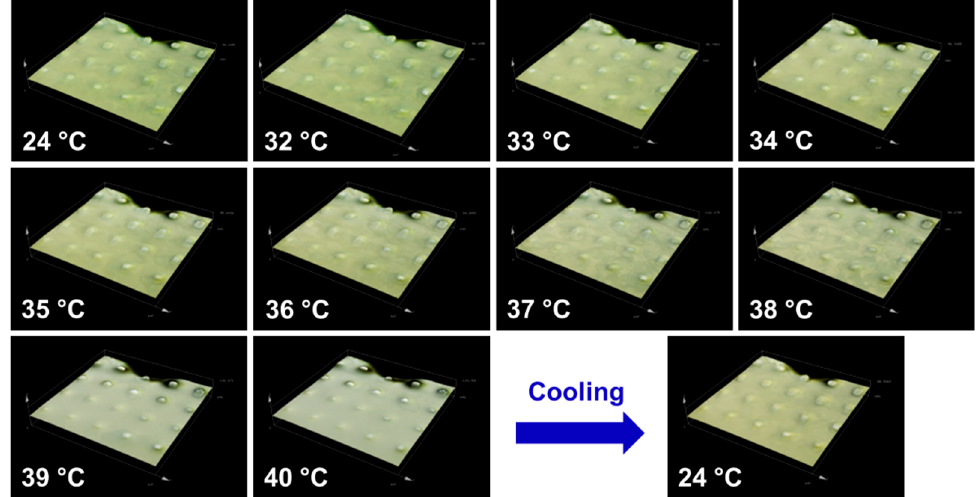
Figure 6. Three-dimensional micrographs of the microlens array with topographical surface change at various temperatures.